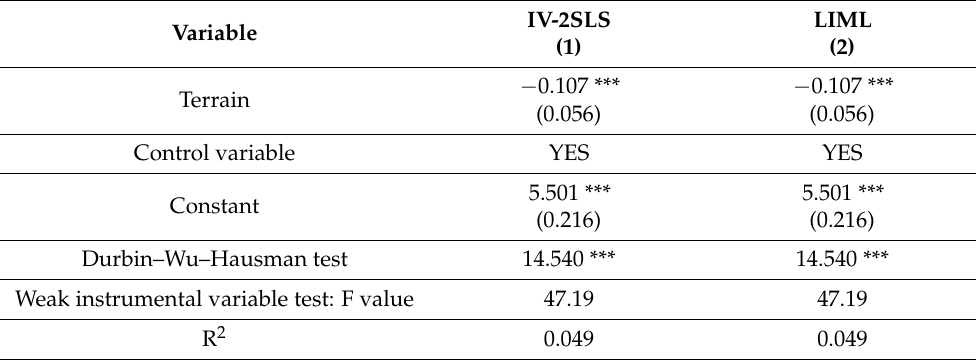
Table 3. Socialized services of green production and fertilizer reduction: endogenous